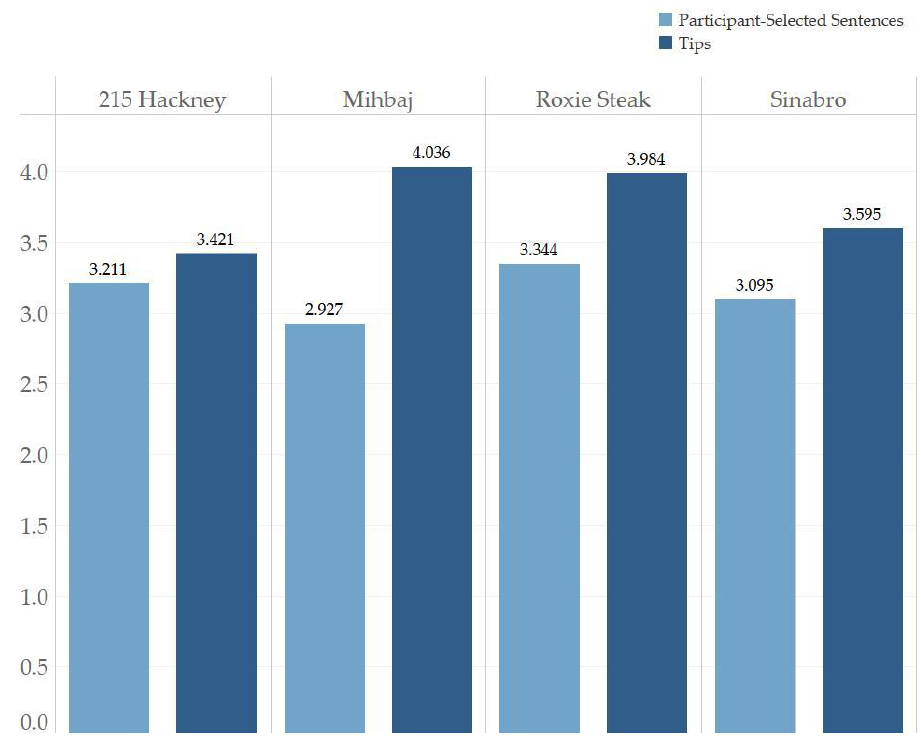
Figure 9. The usefulness of tips and participant-selected sentences. Table 6. Result of Study A3.